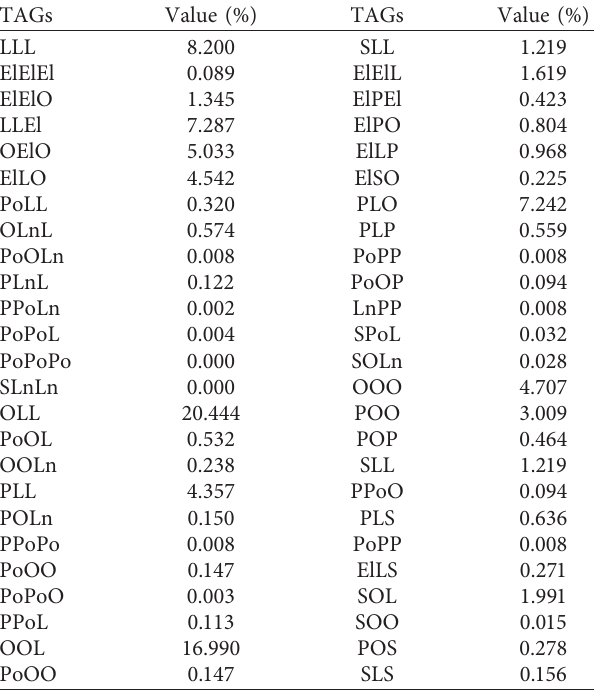
Table 3: TAGs composition of sour cherry kernel oil.